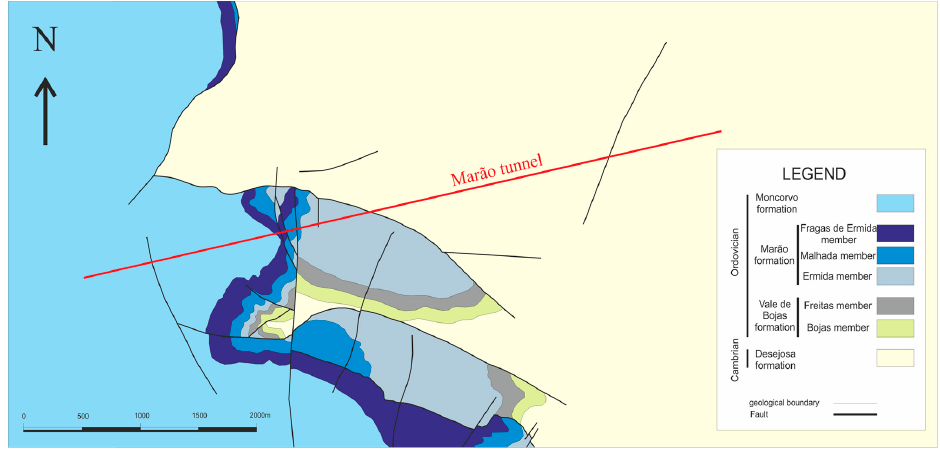
Figure 6. Infographics of the geological settings of Marão tunneling (TM) (adapted from [40]).